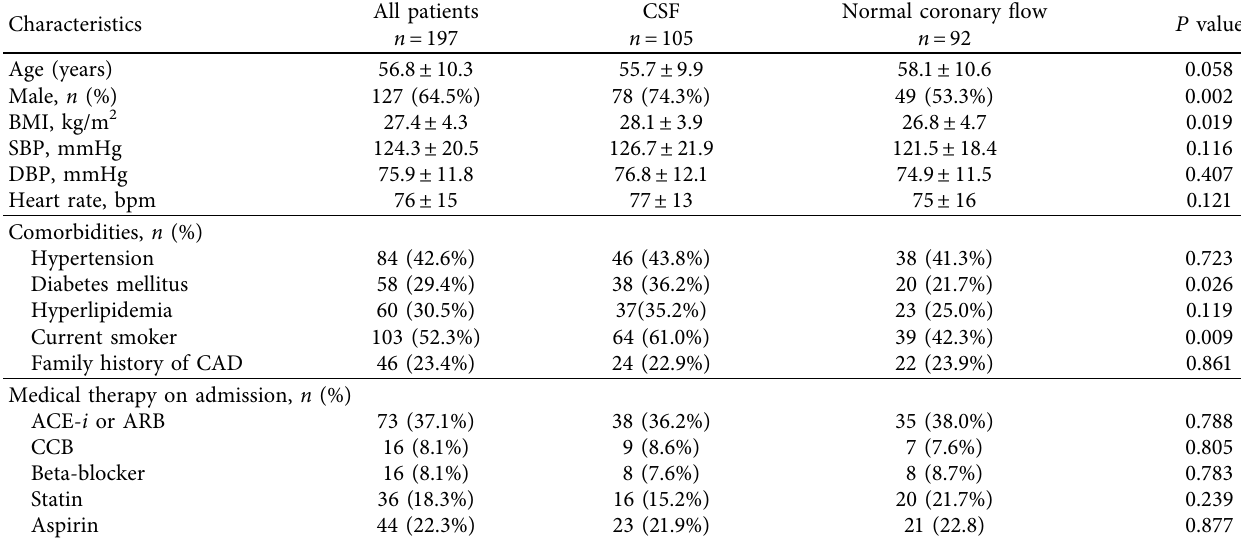
Table 1: Baseline clinical characteristics of the patients with coronary slow fow and normal coronary fow.